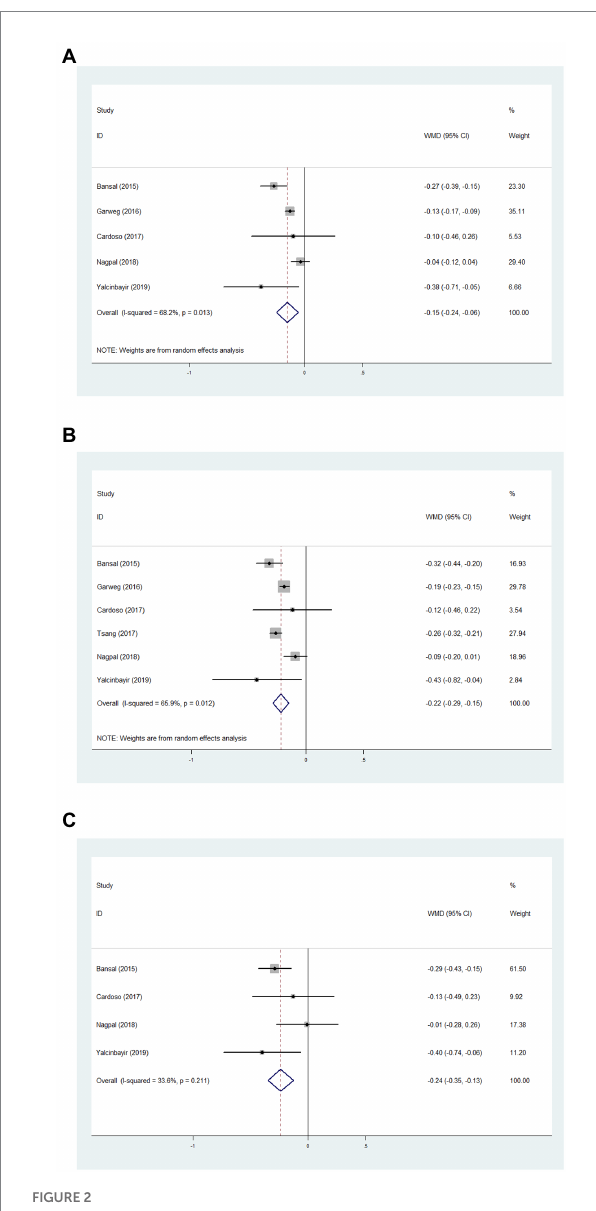
FIGURE 3 Forest plot showing central macular thickness changes from baseline to 1 (A) , 3 (B) , and 6 months (C)